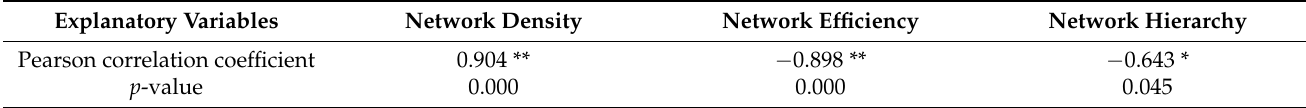
Figure 6. Network hierarchy and network efficiency. Table 3. Correlation between tourism eco-efficiency and overall network structure